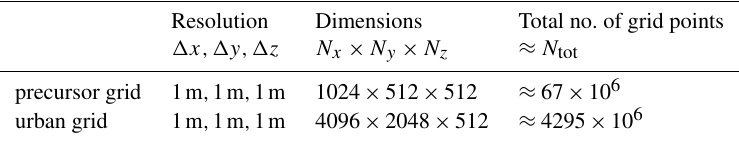
Table 1. Computational grid